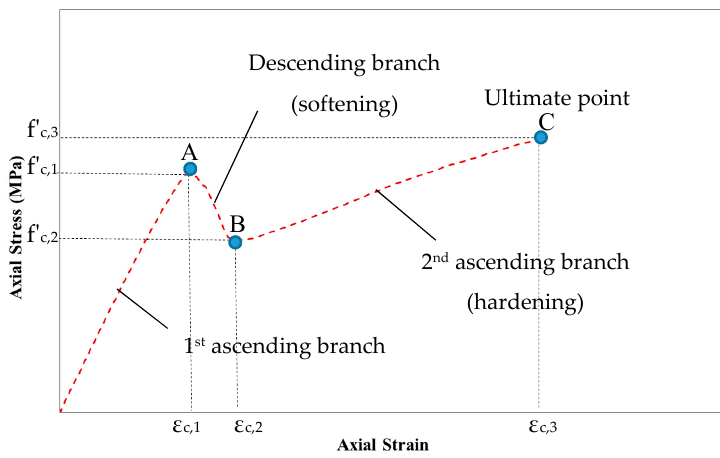
Figure 7. Three points (A, B and C) considered in modeling.